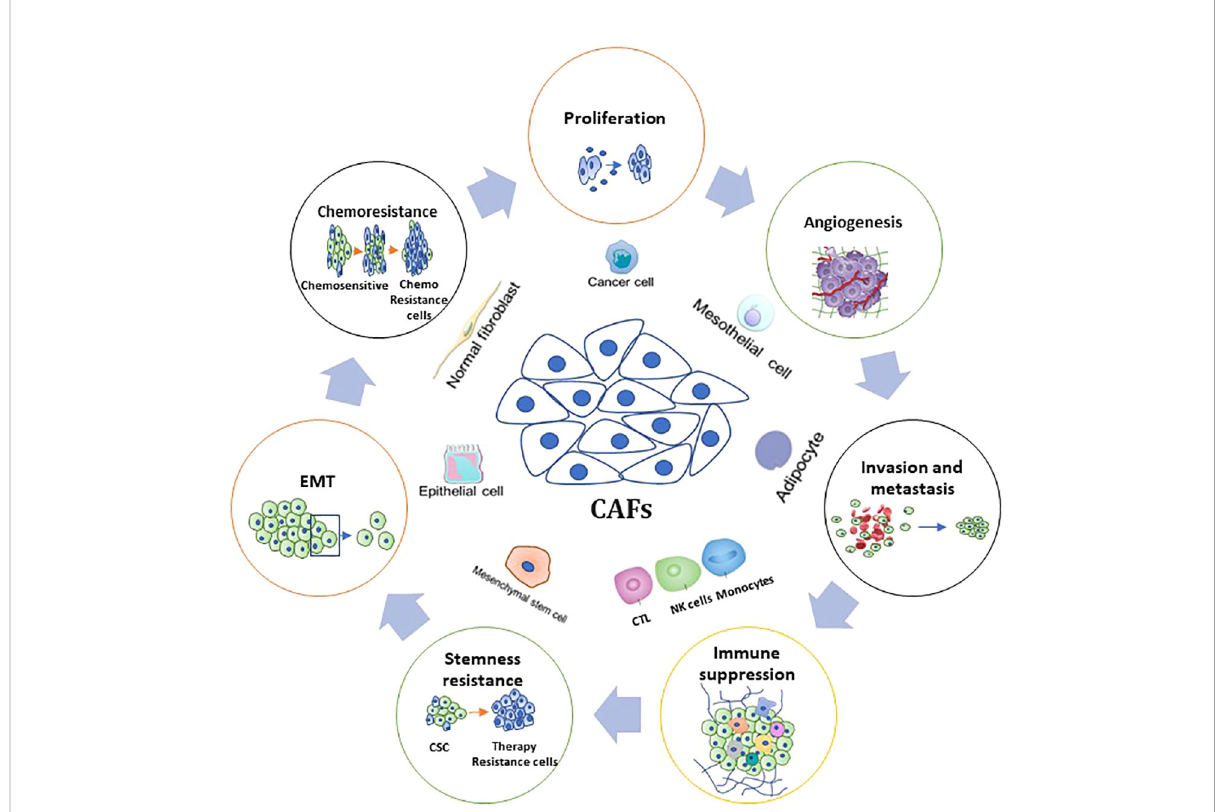
FIGURE 3 Fundamental Functions and associated mechanisms of CAFs in CRC hallmarks. The fi gure shows the role of CAFs in CRC biology, including tumorigenesis, proliferation, angiogenesis, invasion and metastasis, stemness, therapy resistance, and tumor